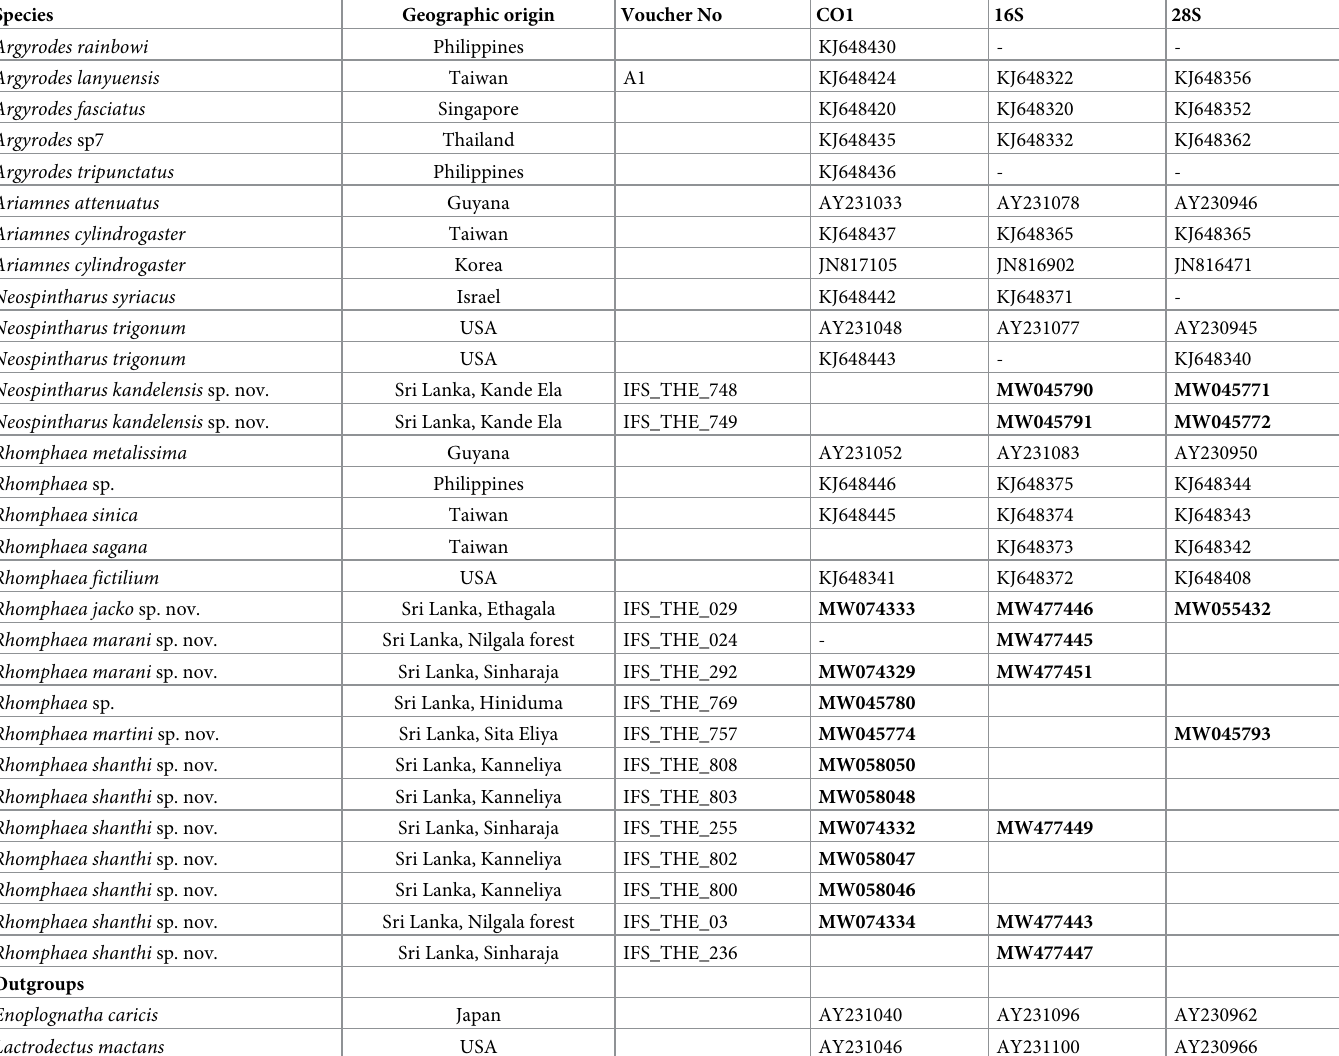
Table 1. Details of exemplars used in this study including collection localities, GenBank accession numbers and National Institute of Fundamental Studies (NIFS) voucher numbers. Accession numbers in bold denote sequences generated for this study. All species belong to the family Theridiidae.